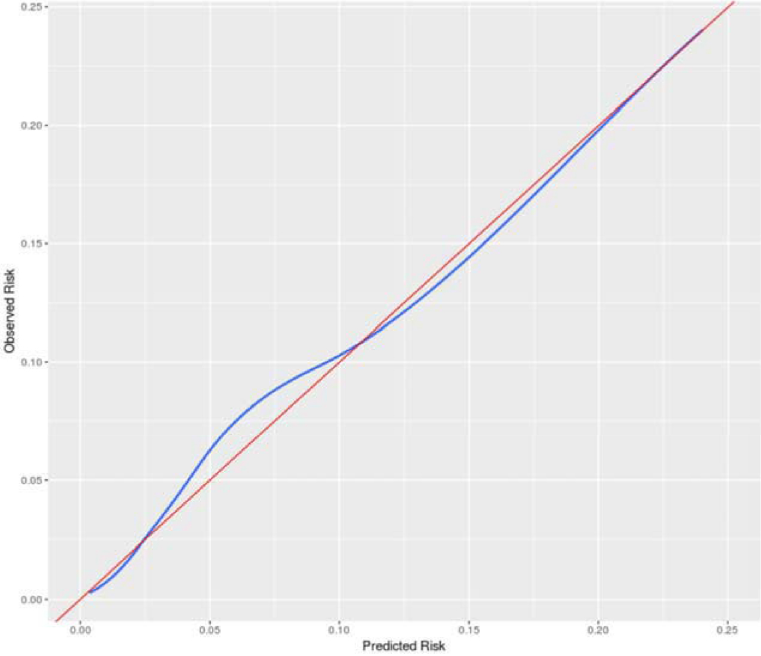
Appendix Figure 2a: Calibration plot for